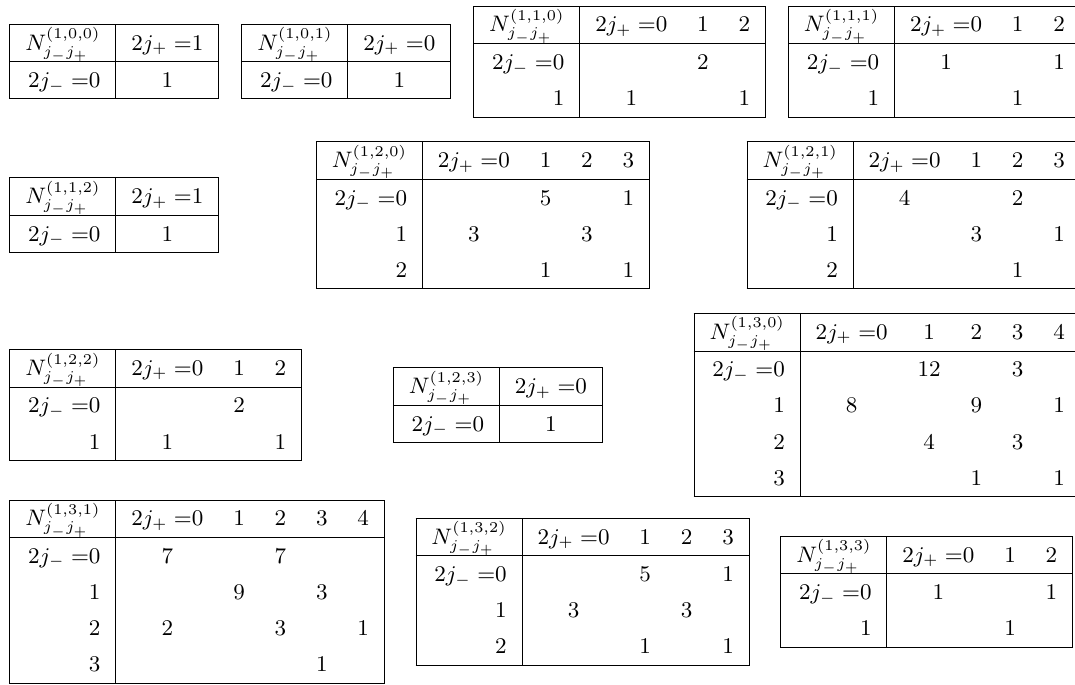
Table 9 . Refined BPS invariants of the massive M-string at base degree b = 1 and e